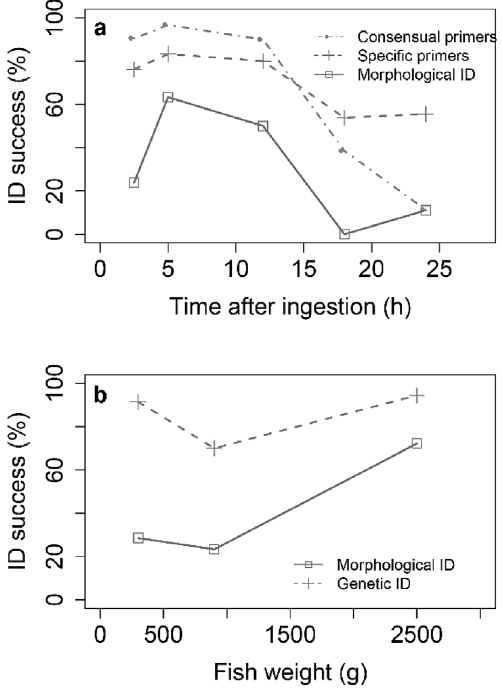
Fig. 2. E ff ect of digestion time (a) and fish mass (b) on morphological and genetic (with universal and specific primers) prey identification success. In (b), genetic identification success includes the use of uni- versal and specific primers.